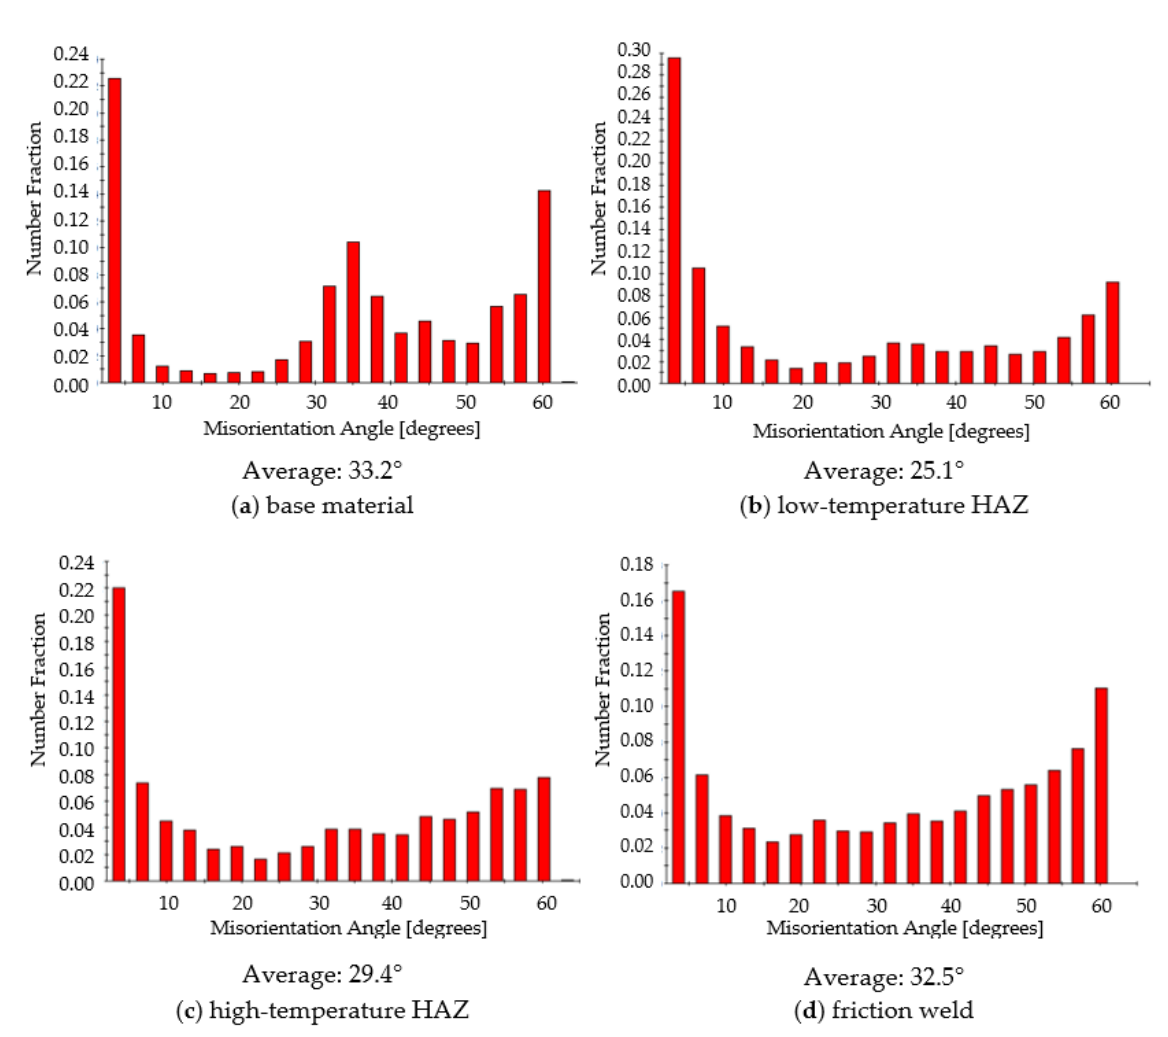
Figure 10. Distribution of misorientation angles in individual areas of the friction joint (corresponding to the IPF maps in Figure 7).